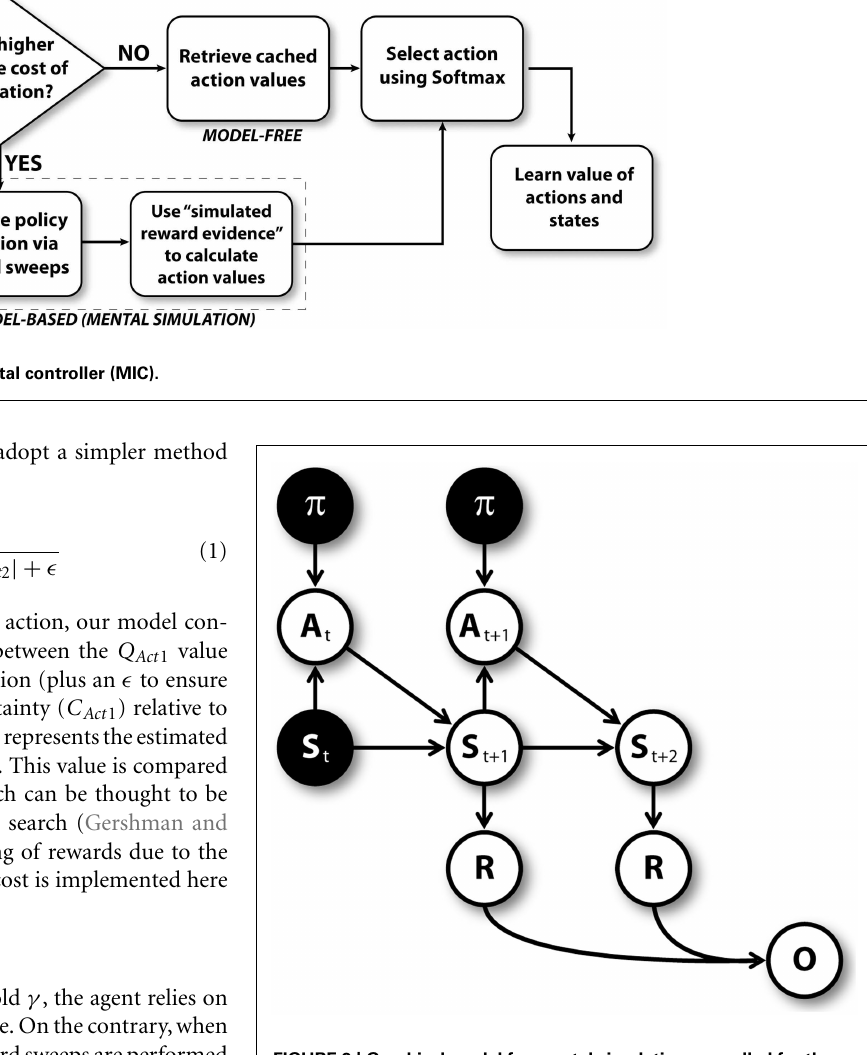
FIGURE 3 | Graphical model for mental simulations, unrolled for three time steps. Filled nodes are “clamped” (i.e., considered as observed) during mental simulation (see Table 1